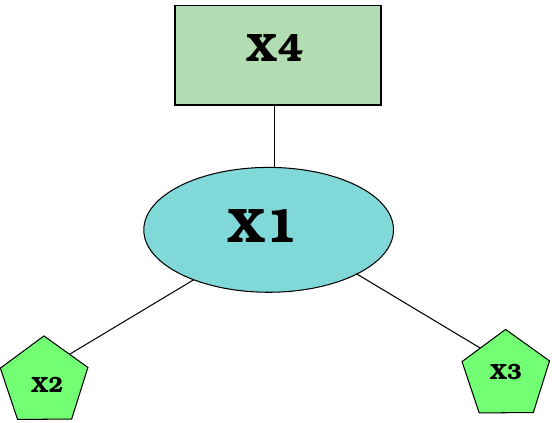
Figure 3. Example of a furniture graph with four nodes and three edges. The shape of the node correspond to a type of geometric